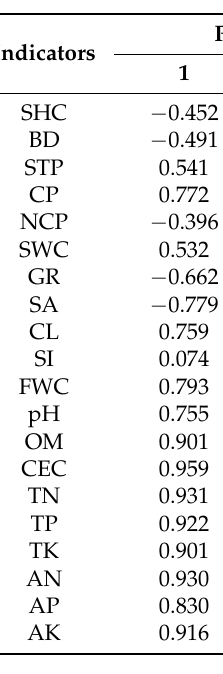
Table 3. Initial factor loading matrix and